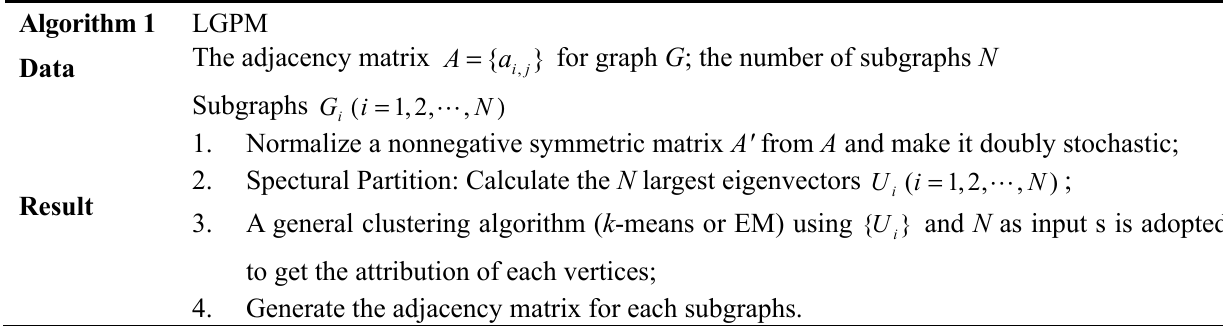
Table 3. Work flow of the L-bounded Graph Partition Method (LGPM)